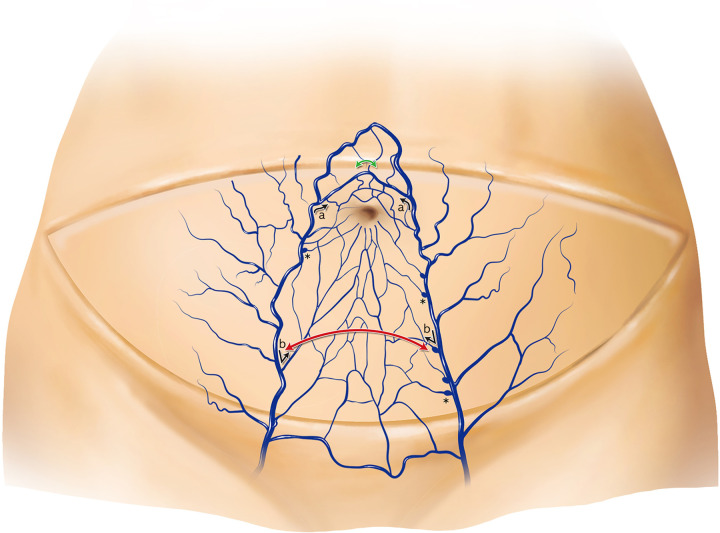
Schematic illustration of the venous structure of the lower abdomen.The supraumbilical midline crossover shows a shorter distance than the infraumbilical midline crossover (green curved arrow vs. red curved arrow). From the main superficial inferior epigastric vein to the medial branch, the angle is more acute in the infraumbilical area (b) than in the supraumbilical area (a) according to the venous flow in the deep inferior epigastric perforator flap. Diverticulum-like projections: valve structures are present near the point of contact of the medial branches of the superficial inferior epigastric vein (asterisks).